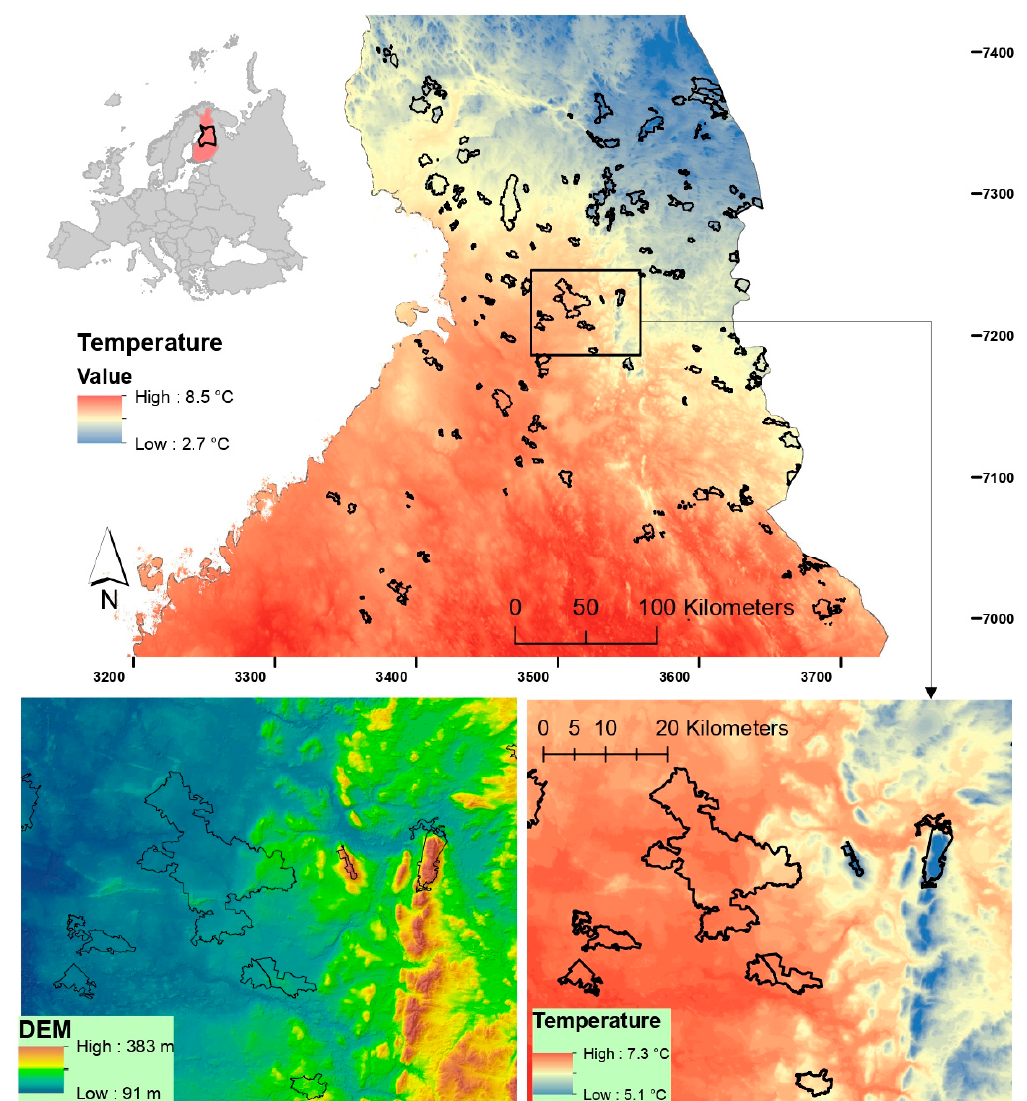
Figure 1. Location of the study areas (protected areas (PAs) in black lines) in Finland with the mean air temperature for April–May–June at 50 m × 50 m grid size. As an example, the topographic variation (meters above sea level; DEM = digital elevation model) and mean April–June air temperatures are shown for a specific region with a high variation in temperature caused by variation in topographic heterogeneity.